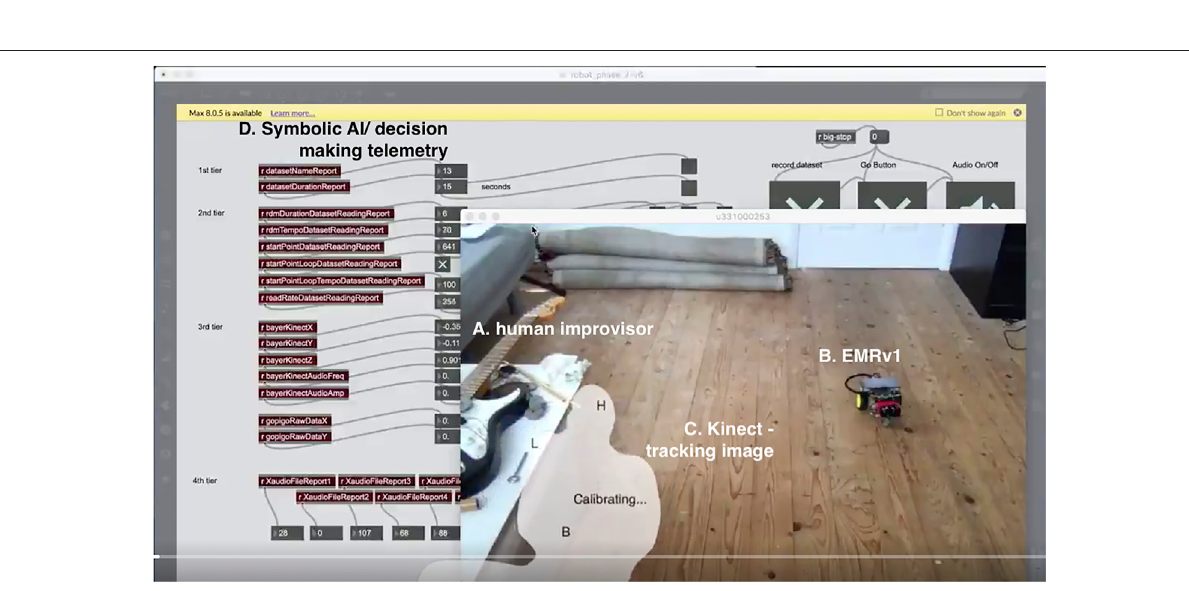
Frontiers in Robotics and AI |